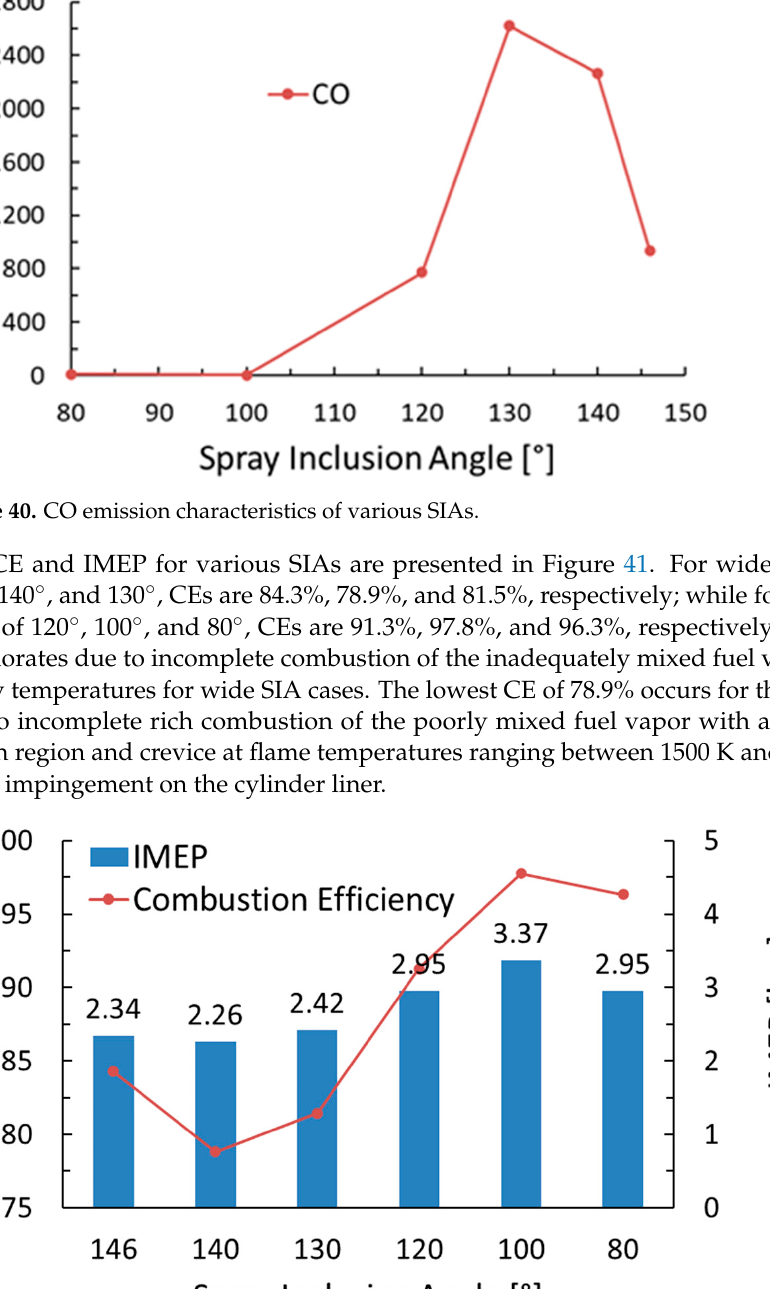
8 3.4. Discussion According to the performance and engine-output emissions calculated via CFD sim- ulations in this study of a single-cylinder HDDI diesel research engine with a stepped-lip piston bowl operating at a partial load, the following conclusions are obtained: In a single-injection strategy, for a given spray-inclusion angle, engine operation is optimal with near-zero NOx emissions at a certain SOI timing. In the PCCI operation, optimum net-indicated efficiency, indicated specific fuel con- sumption, and NOx, soot, and CO emissions are achieved by preventing or minimizing